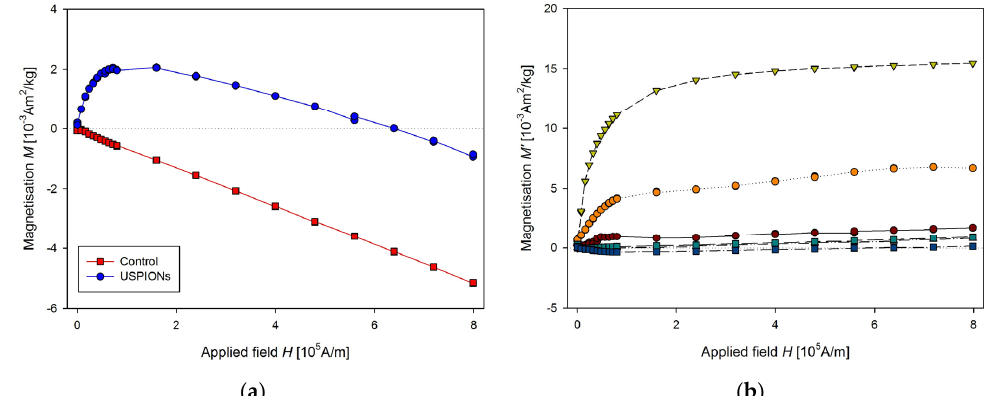
Figure 15. Magnetic properties of the blood of control and USPION-treated rats. ( a ) The partial M ( H ) dependences at 300 K and ( b ) corresponding M ’ data for individual rats of the USPION treated group after subtraction of the control group average (b). Data (a) are presented as the averaged curve from the control group ( n = 4) and USPION-treated group ( n = 6). The mass of dry samples was in the range of 1.3–2.3 mg.